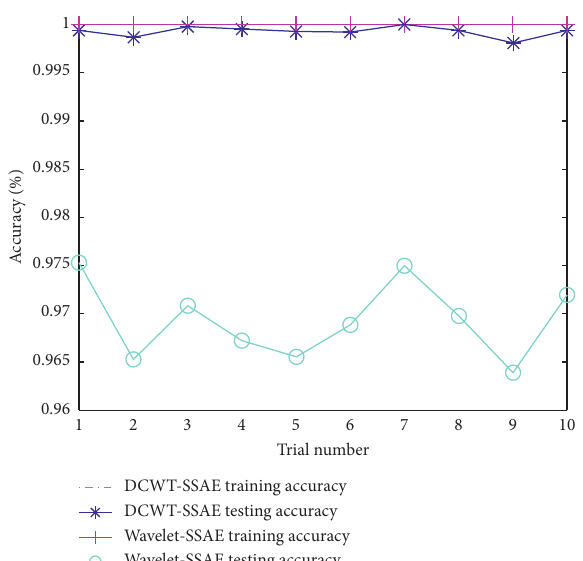
Figure 11: Diagnosis results comparison of 10 trials of worm gear dataset.